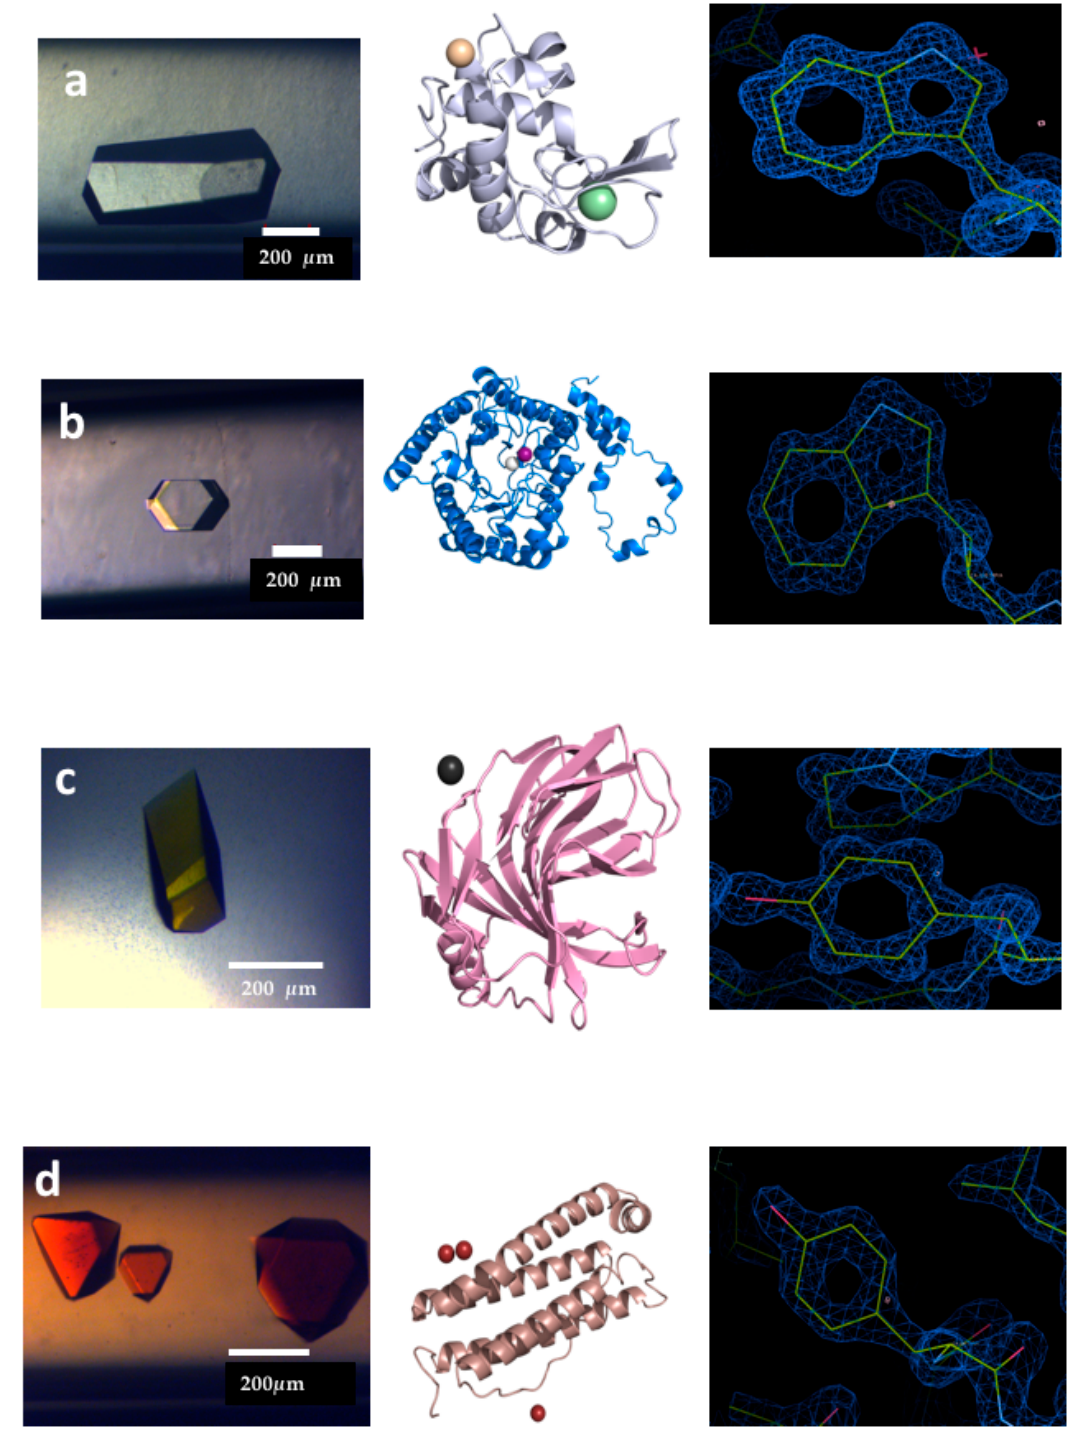
Figure 4. This shows the crystal shape and crystal structure as well as the high-resolution electron density map (2F 0 –F c ) for ( a ) lysozyme, ( b ) glucose isomerase, ( c ) xylanase and ( d ) ferritin respectively. Contour level was 2.5–2.3 σ due to the high resolution